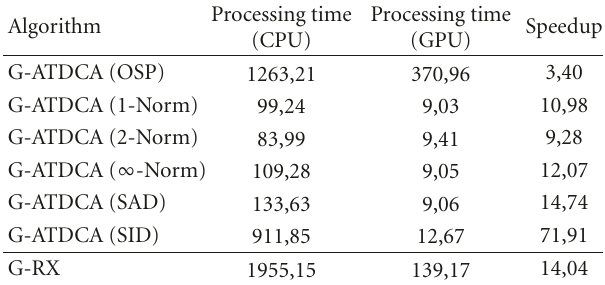
Table 8: Processing time (seconds) and speedups measured for the CPU and GPU implementations of several target and anomaly detection